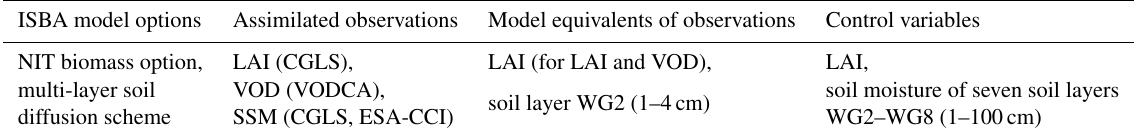
Table 1. LDAS-Monde configuration used in this study. ISBA model options Assimilated observations Model equivalents of observations Control variables NIT biomass option, LAI (CGLS), LAI (for LAI and VOD), LAI, multi-layer soil VOD (VODCA), soil moisture of seven soil layers soil layer WG2 (1–4cm) diffusion scheme SSM (CGLS, ESA-CCI) WG2–WG8